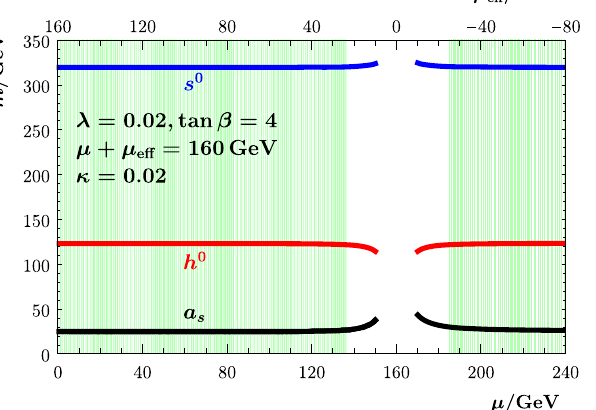
with the opposite sign of (μ eff ˜ κ) . The other parameters are given in Table 1. The green area indicates compatibility with the constraints from HiggsSignals